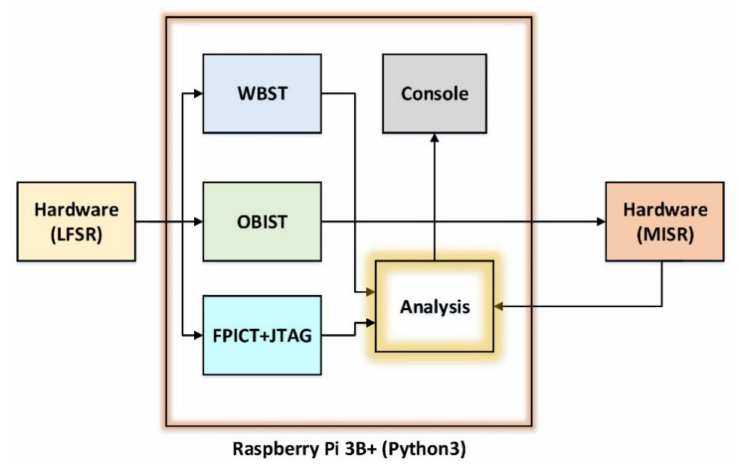
Figure 4. Proposed combined testing suite for improving the solar reliability